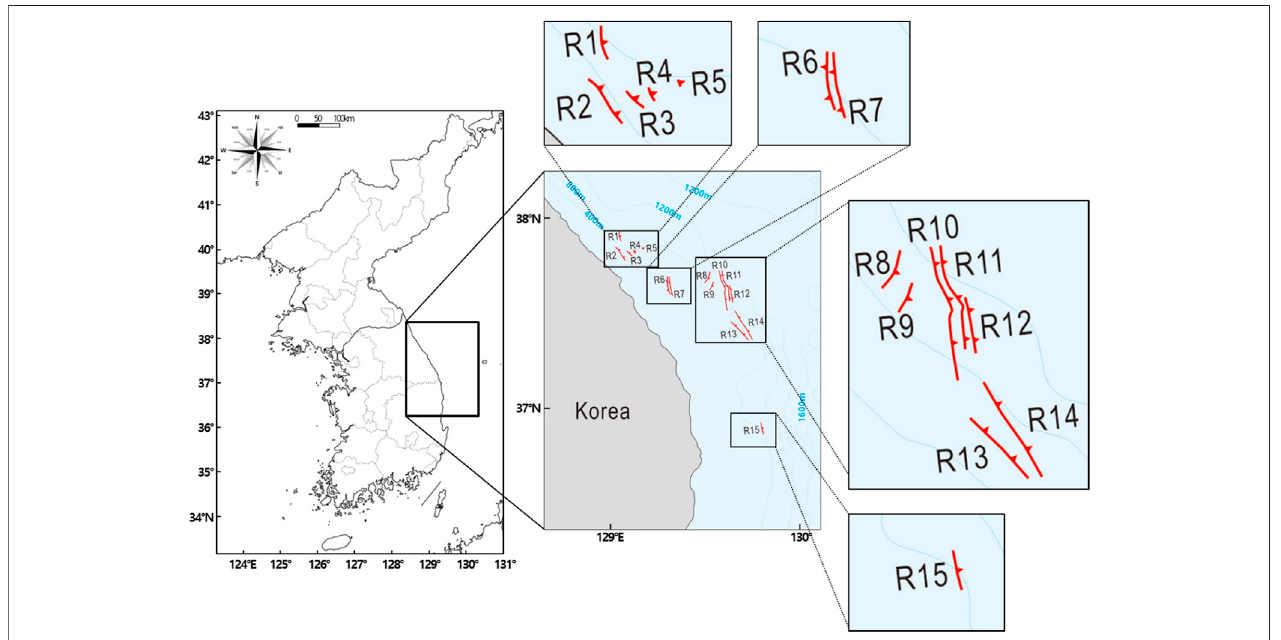
FIGURE 3 | Major East Sea fault zones identi fi ed from the fault/seismic databases described in Section 2.1 Scenarios R1 – R15 refer to tsunamis generated by earthquakes caused by rupture on each of the 15 different fault zones.